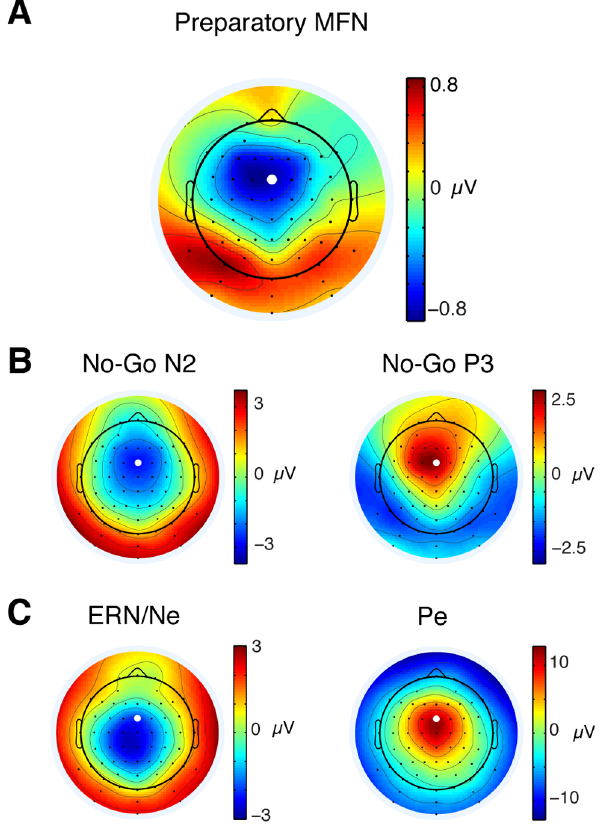
Figure 4. Topographical maps. Black dots represent locations of electrodes, and the white dot represents the location of the fronto- central electrode where the ERPs were plotted. ( A ) Preparatory medial frontal negativity time-locked to the onset of the preview display (448– 528 ms post-stimulus). ( B ) No-Go N2 (left) and P3 (right) time-locked to the onset of the Go/No-Go signal (228–308 and 352–432 ms post- stimulus, respectively). ( C ) Error related negativity (ERN/Ne, left) and positivity (Pe; right) time-locked to the end-of-trial event (error or successful completion of the maze; 56–136 and 308–388 ms post- stimulus,